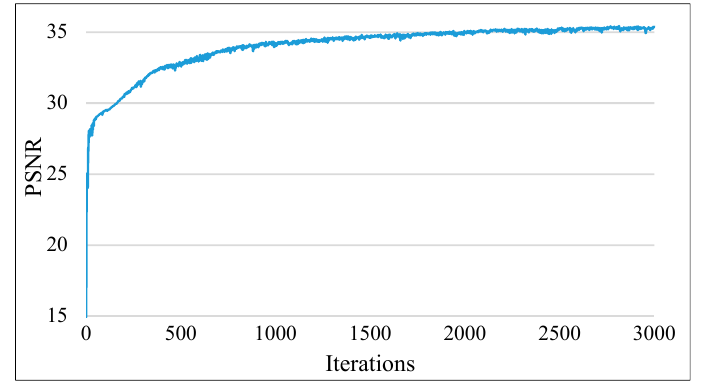
Figure 10. The Peak signal-to-noise ratio (PSNR) values versus iterations when the upscale factor is 4.